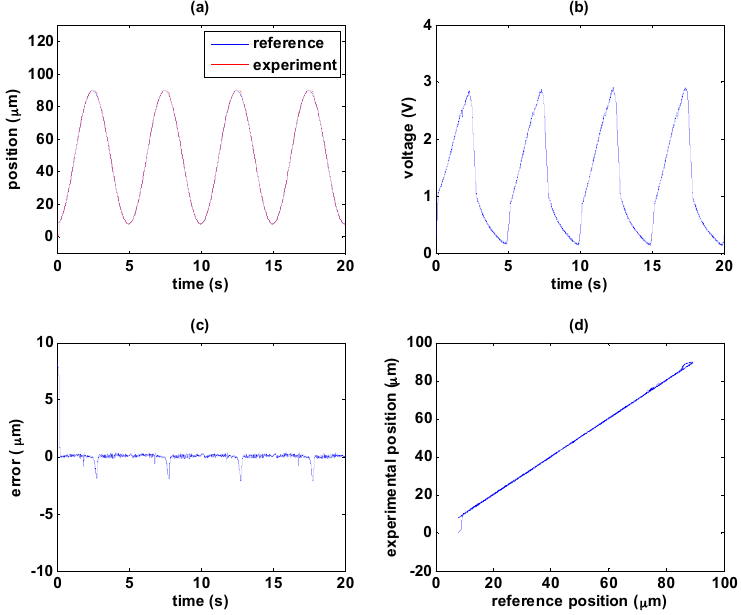
Figure 13. Path tracking of sinusoidal wave with MFSMC: ( a ) path tracking responses; ( b ) control signals; ( c ) control errors; ( d ) linear relationship between reference and experimental positions.